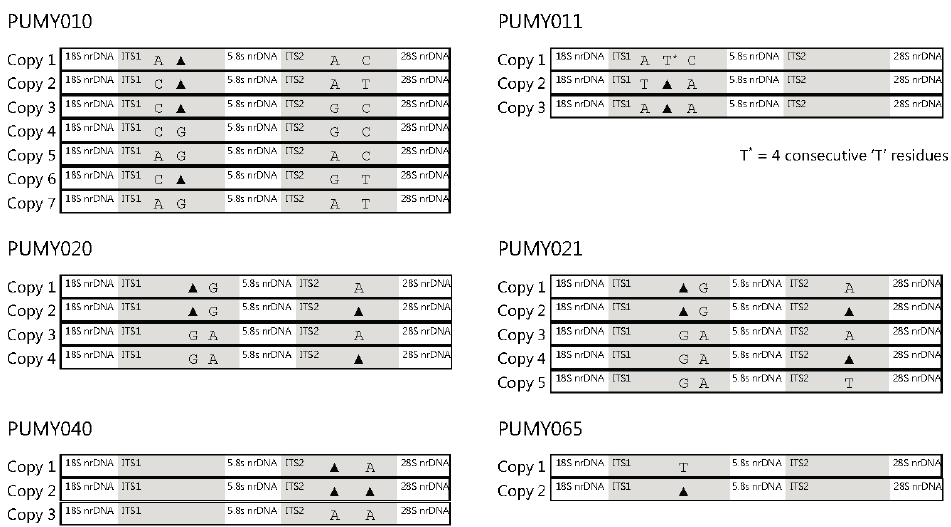
Figure 1. Schematic diagrams showing the multiple alignments of ITS sequences of the six yeast isolates. The internal transcribed spacer regions ITS1 and ITS2 are highlighted in gray. Intra-genomic polymorphisms are represented by the corresponding nucleotides or the symbol “ ▲ ” (meaning deletion) at the respective sites. The diagrams are not drawn to scale.